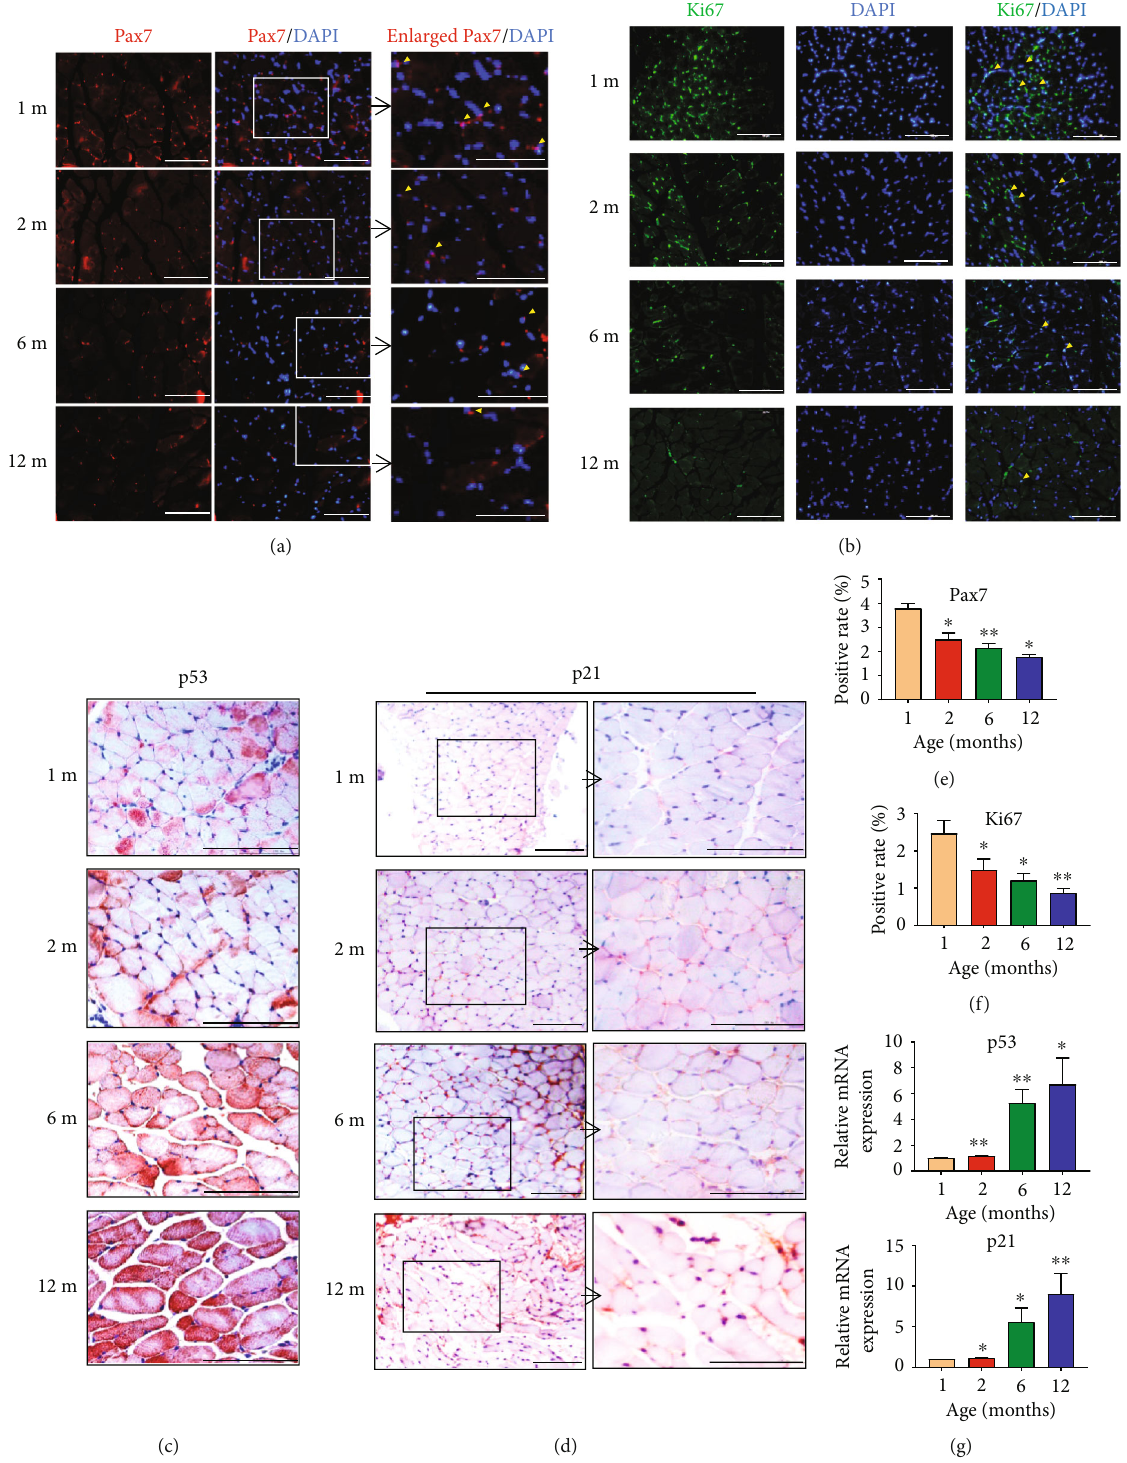
Figure 2: The renewal ability declined and senescence phenotype increased in aging GG. (a) Pax7, Pax7/DAPI, and enlarged Pax7/DAPI detected in GG muscles. (b) DAPI, Ki67, and Ki67/DAPI were detected in GG muscles. (c) The protein level of p53 was signi fi cantly increased in 12-month-old GG. (d) The protein level of p21 dramatically increased in 12-month-old GG compared to 1-month-old, 2-month-old, or 6-month-old. (e) Pax7-positive cells in GG signi fi cantly reduced in 12-month-old compared to 1-month-old. (f) Ki67-positive cells in GG greatly reduced in 12-month-old compared to 1-month-old. Ki67 was observed by immuno fl uorescence staining. (g) The mRNA levels of p53 and p21 also upregulated in aging GG. ∗ p < 0 : 05 and ∗∗ p < 0 : 01 . Scale bars are 100 μ